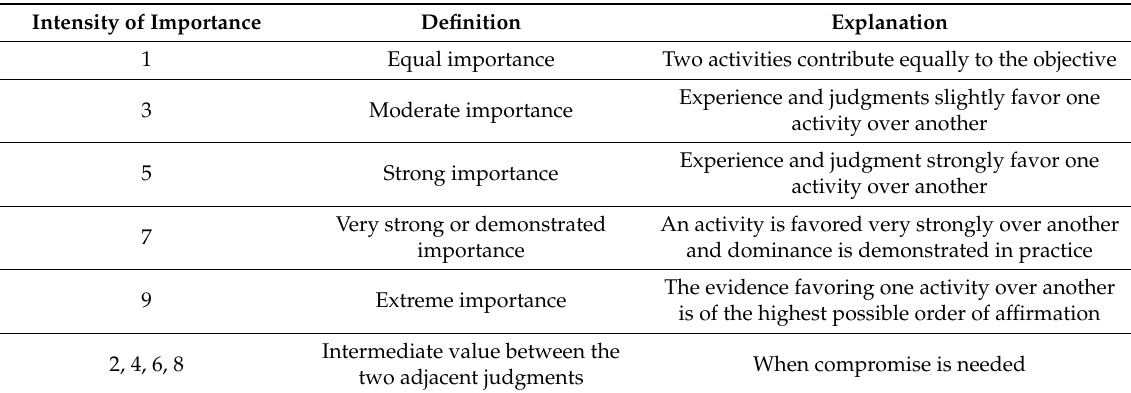
Table 1. Scale of Relative Importance. Source: [31].